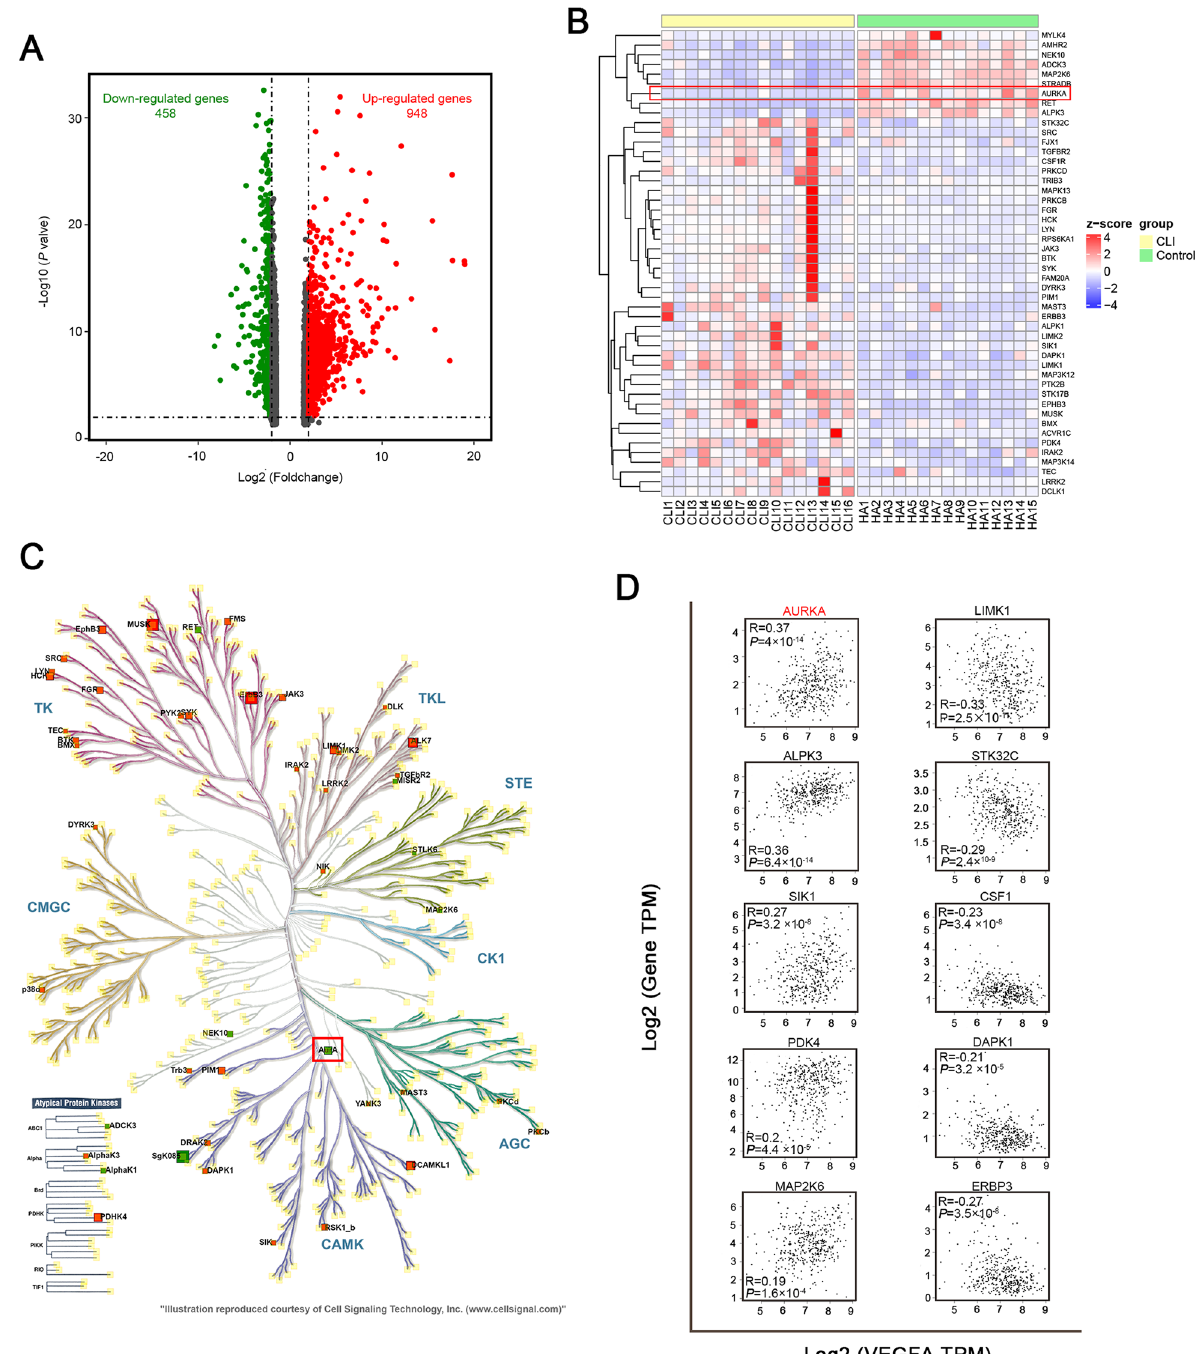
Fig. 1 Expression of kinases in CLI. The differential genes in CLI were analyzed using GSE120642 dataset, and shown in volcano ( A ). The changes of differential expressed kinases were exhibited in heat map ( B ). Distribution of changed kinases levels was shown over the human kinome tree ( C ). Increased levels of kinases were in red, and decreased were in green. The square sizes reflected Log2 Fold change (Log2FC) ( C ). Verification of the correlation of VEGFA and the differentially expressed kinase genes using GEPIA ( D